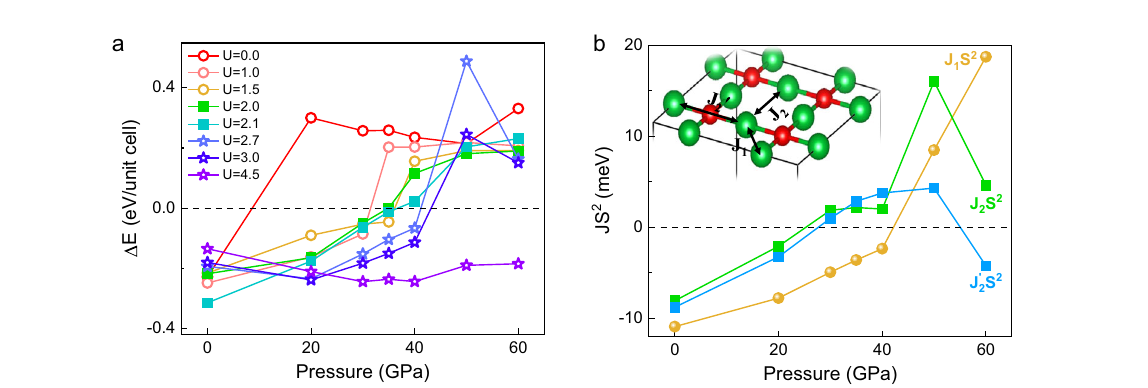
Fig. 4 | Theoretical investigation of pressure-induced magnetic transition. a magnetic phase transition of La 2 O 3 Fe 2 Se 2 polycrystal within different Hubbard U values. b Exchange coupling parametersas afunctionof pressurewithin U =2.1eV. The inset illustrate three exchange interactions, including the nearest-neighbor